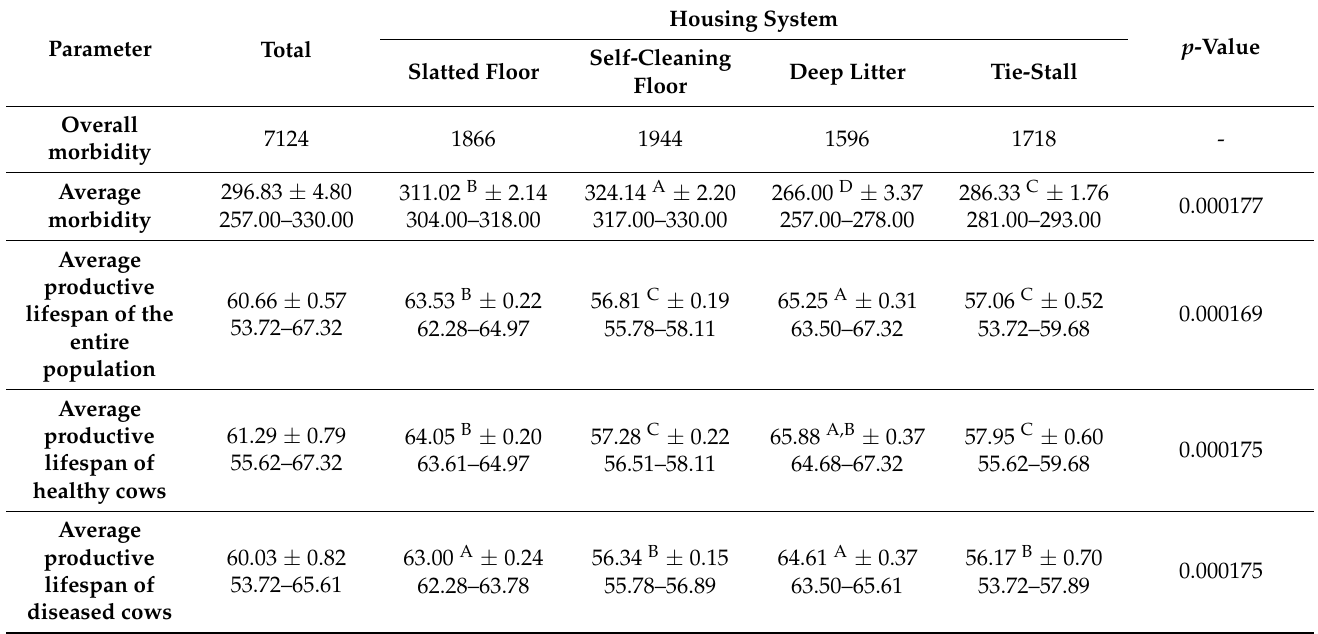
Table 2. Overall ( Σ ) and average ( ± SEM; minimum–maximum) morbidity in the studied population of dairy cows and productive herd life (in months) in different housing systems in 2015–2020.